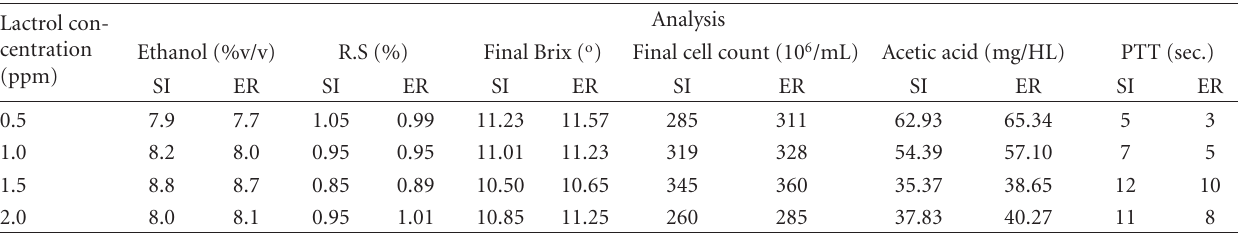
∗ SI: Saf-Instant and ER: Ethanol